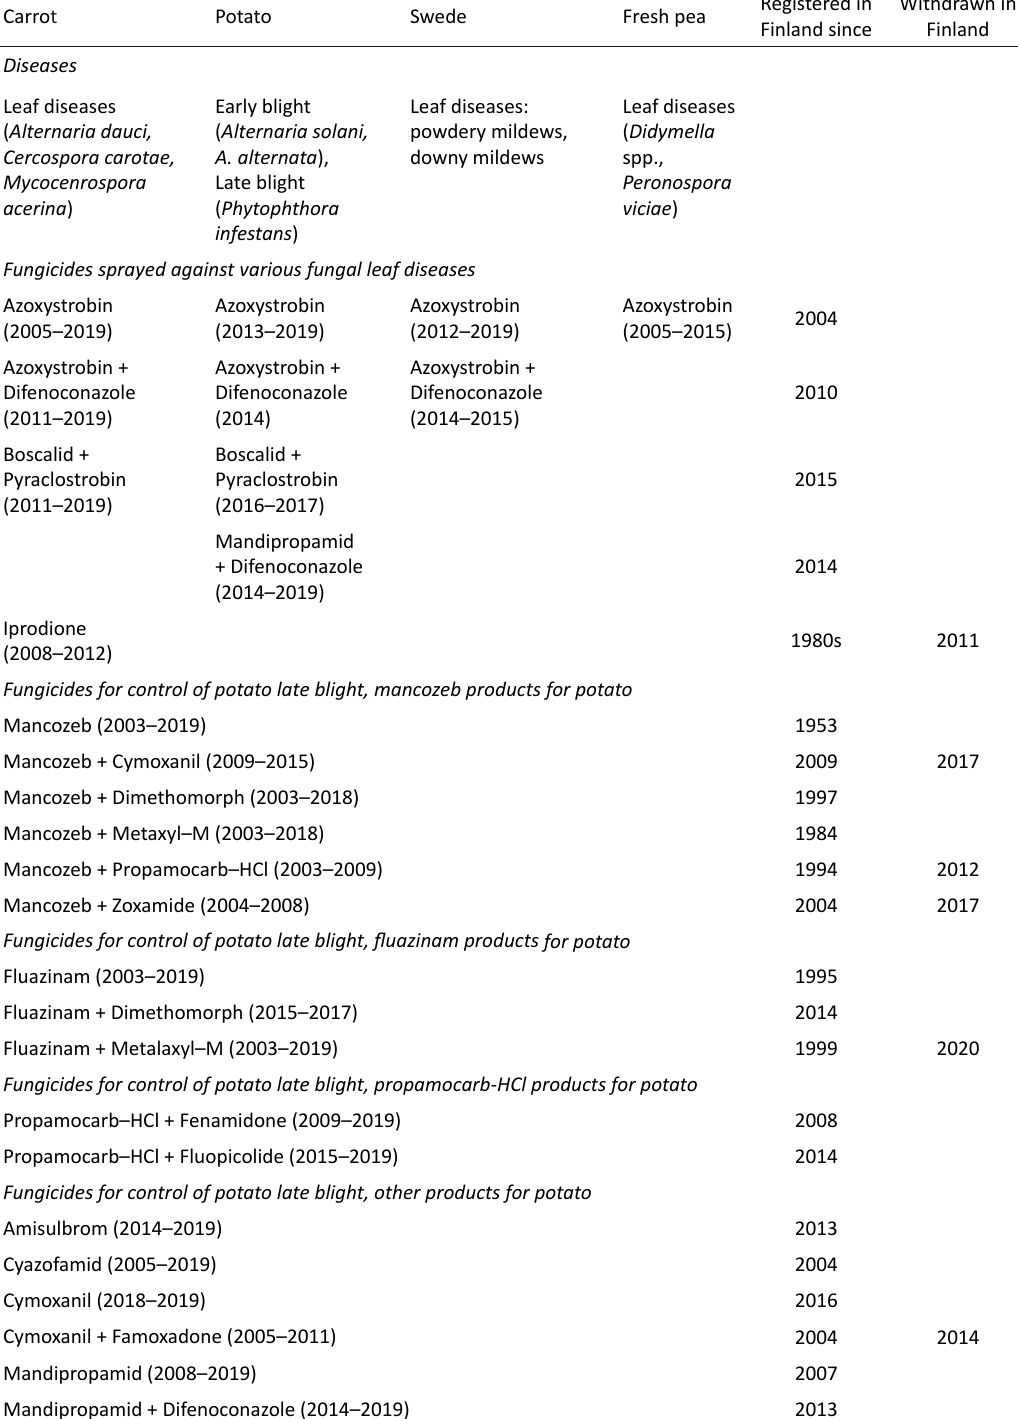
Table 4. The most common diseases (Natural Resources Institute Finland 2021c) and the fungicides used for their control in studied crops (the database of Apetit Ruoka Ltd.), the year of registration and withdrawal from the Finnish market, and derogations of non-registered PPPs (Finnish Safety and Chemicals Agency